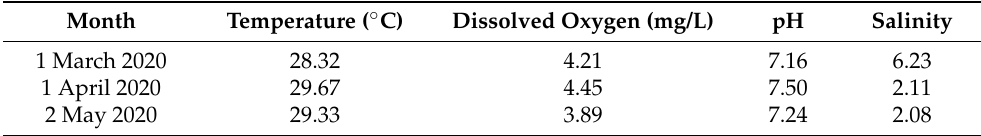
Figure 1. The location of sampling area at Setiu Wetland, Terengganu. The online map service retrieves from (https: //www.google.com.my/maps/search/setiu+wetland/@4.2777739,101.7082448,7.36z) via Google map. Table 1. The in-situ parameters of the sampling